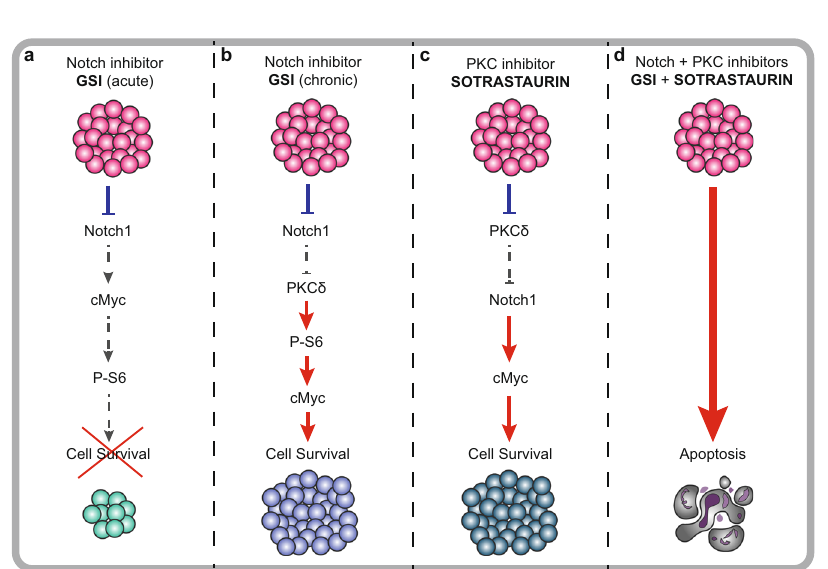
Fig. 9 Graphical model for therapeutic inhibition of Notch and PKC in T-ALL cells to prevent drug resistance. a In sensitive cells, NOTCHi leads to downregulation of its transcriptional target cMyc, which in turn regulates S6 phosphorylation in a mTORC1-dependent manner. b After chronic administration of Notch inhibitors, cells adapt to Notch absence through the upregulation of PKC δ , which phosphorylates S6 and sustains cMyc expression in a Notch-independent manner. c Notch and PKC δ activation show a mutually exclusive pattern. In fact, PKC inhibition by sotrastaurin leads to upregulation of cMyc expression. d The combined inhibition of Notch and PKC has a synergistic effect and fully inhibits the development of acquired